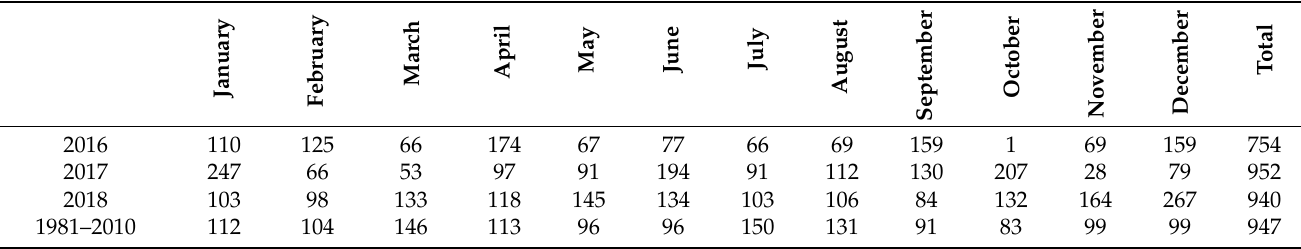
Table 2. Precipitation (mm) from January to December in 2016, 2017, and 2018 and the historic normal (average from 1981 to 2010) at the Dempsey Farm, Griffin,